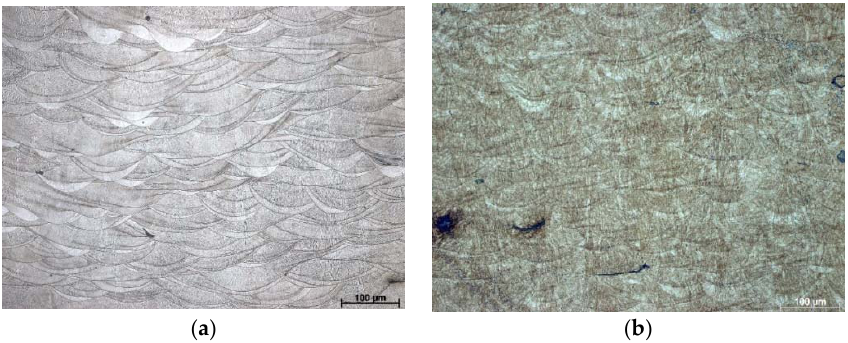
Figure 7. Representative sample: as ‐ built ( a ) and after aging treatment ( b ).